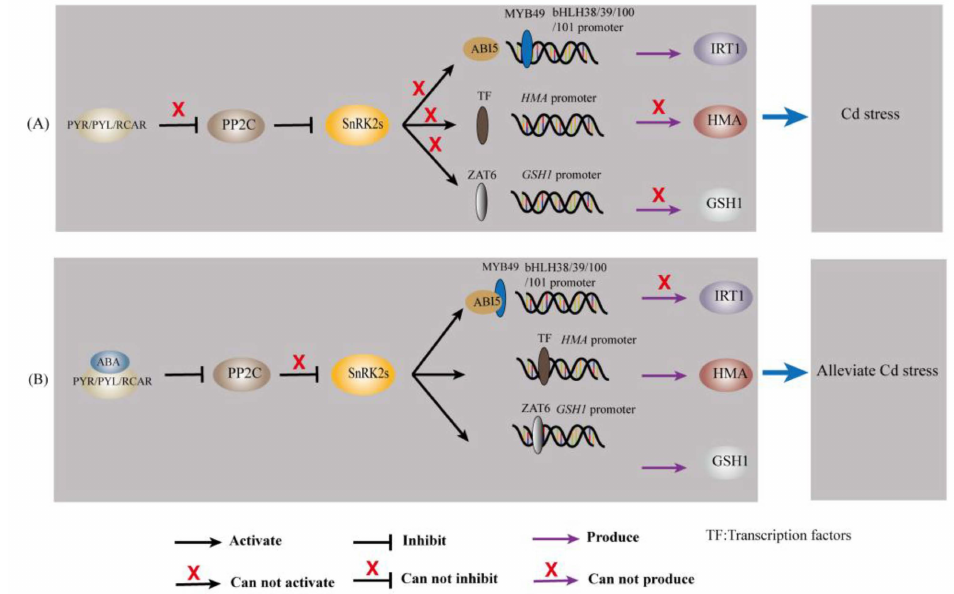
Figure 3. ABA regulates Cd-responsive genes in plants. ( A ) The transcription of IRT1 , HMA , and GSH1 under Cd stress. ( B ) The transcription of IRT1 , HMA , and GSH1 when ABA was involved under Cd stress.